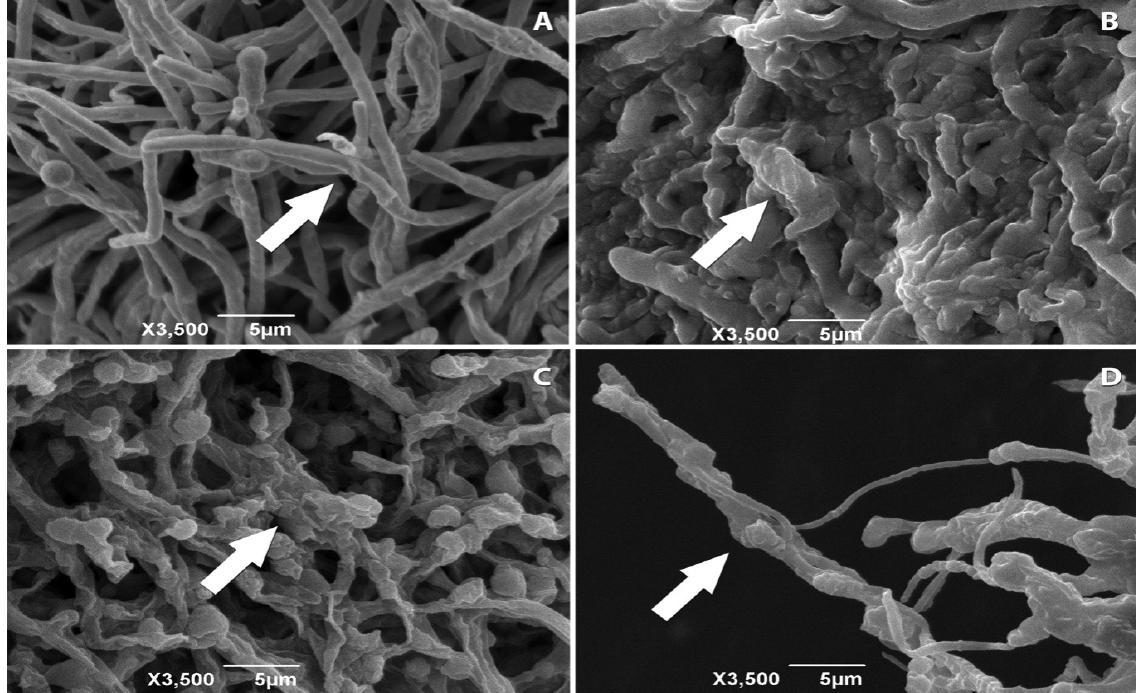
Figure 1. Electron micrographs of T. mentagrophytes ATCC 11481: ( A ) untreated — arrow indicates hyphae with morphological changes; ( B ) treated with copaiba oleoresin — arrow indicates the compression and clusters of hyphae; and ( C ) treated with ketoconazole and ( D ) treated with terbinafine — both arrows indicate the appearance of dried and wrinkled